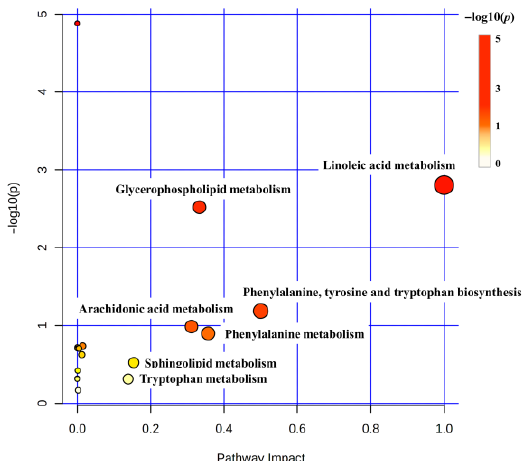
Figure 4. The hepatic pathway analysis based on MetaboAnalyst 5.0. Bubble size is proportional to the impact of each pathway, and bubble color denotes the degree of significance from the highest (red) to the lowest (white).